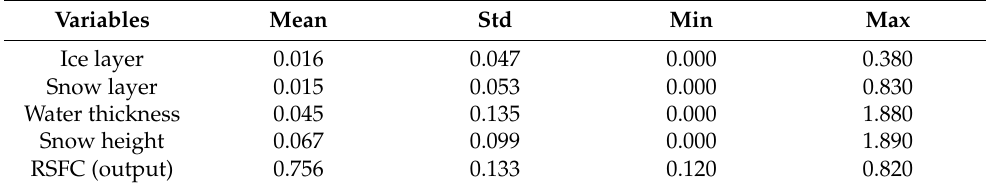
Table 3. Statistical description of the testing